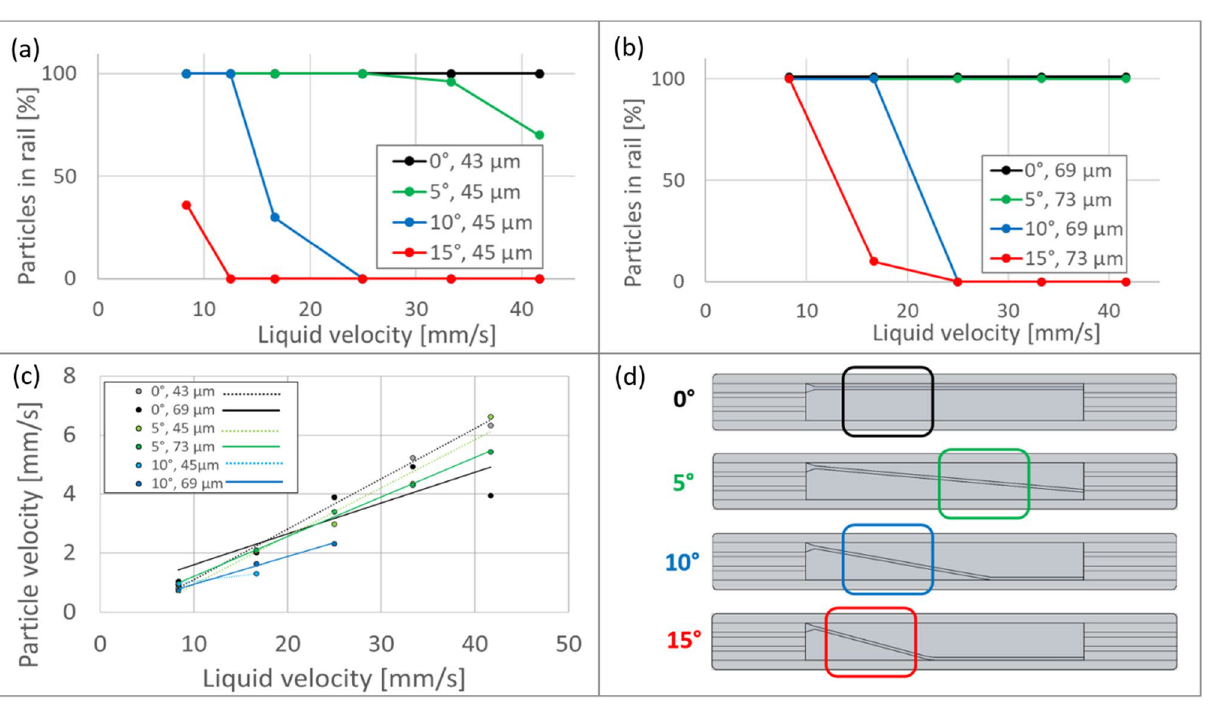
Figure 6. Fraction of the particles of ø 89 µm following the rail of depth ( a ) 45 ± 1 µm and ( b ) 72 ± 1 µm. ( c ) Velocity of particles following a rail. Stability and velocity of particles depends on rail depth, angle, and flow rate of the carrier liquid. ( d ) Scheme of the